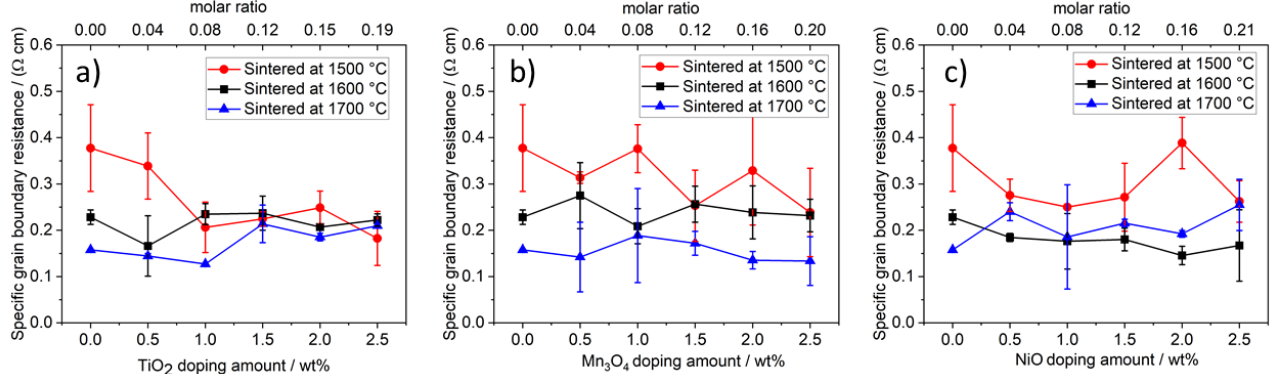
Figure 17. Specific grain boundary resistance of Na- β″ -alumina samples. ( a ) TiO 2 -doped Na- β″ -alumina; ( b ) Mn 3 O 4 -doped Na- β″ -alumina; ( c ) NiO-doped Na- β″ -alumina.